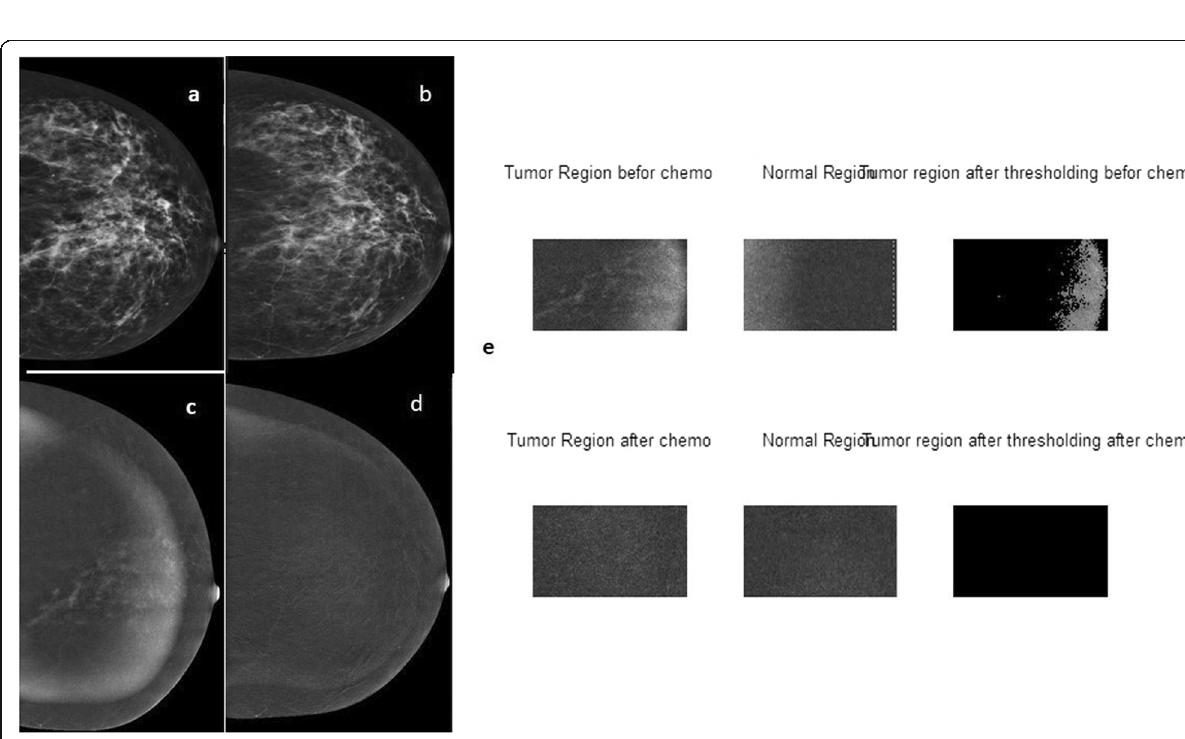
Fig. 6 A 56-year-old patient with ILC of the left breast received neoadjuvant chemotherapy. a Pre NAC mammogram CC view showing a left breast focal asymmetry. b Post NAC mammogram CC view showing reduction in size. c Pre NAC CESM CC view grouped enhancing lesions. d Post NAC CESM CC view showing no residual pathological enhancement. e Quantitative mathematical objective evaluation. RECIST 1.1 classified the patient as partial responder. Combined response evaluation classified this patient as a complete responder. Quantitative mathematical objective evaluation showed 99% regression. Pathological evaluation confirmed this patient as acomplete responder (Miller – Payne grade 5)